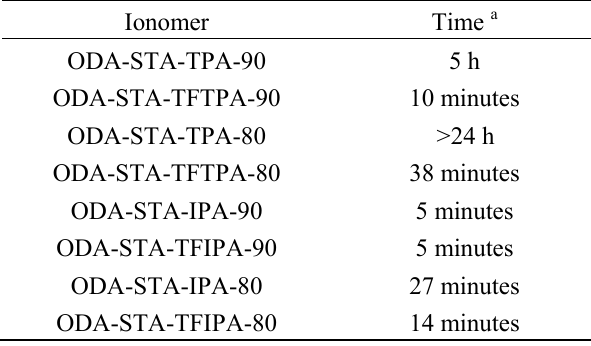
Table 2. Hydrolytic stability of sulfonated poly(ether amide)